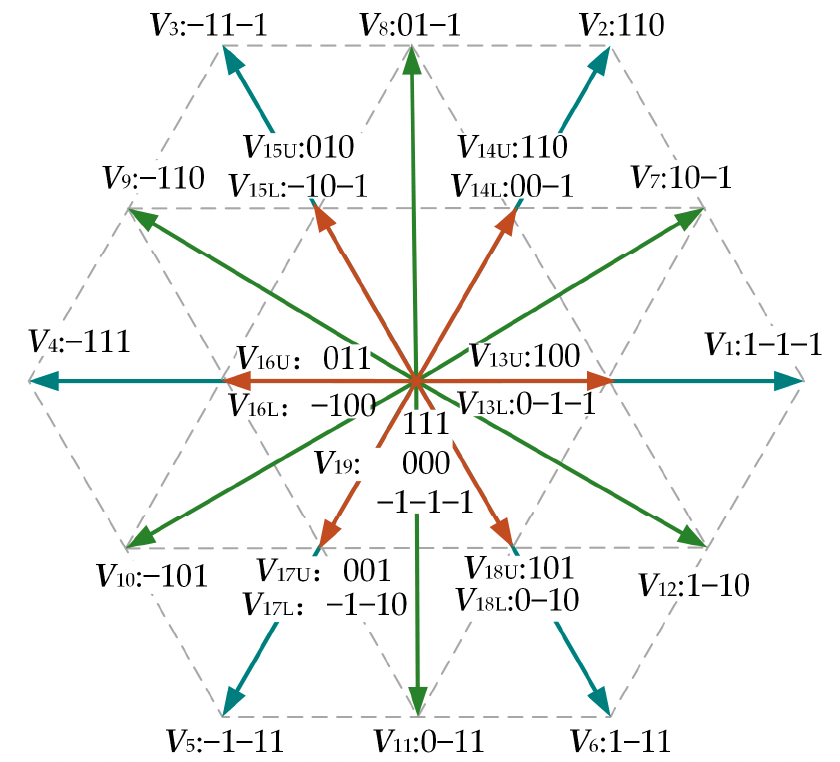
Figure 2. Space Vector diagram of NPC inverter.